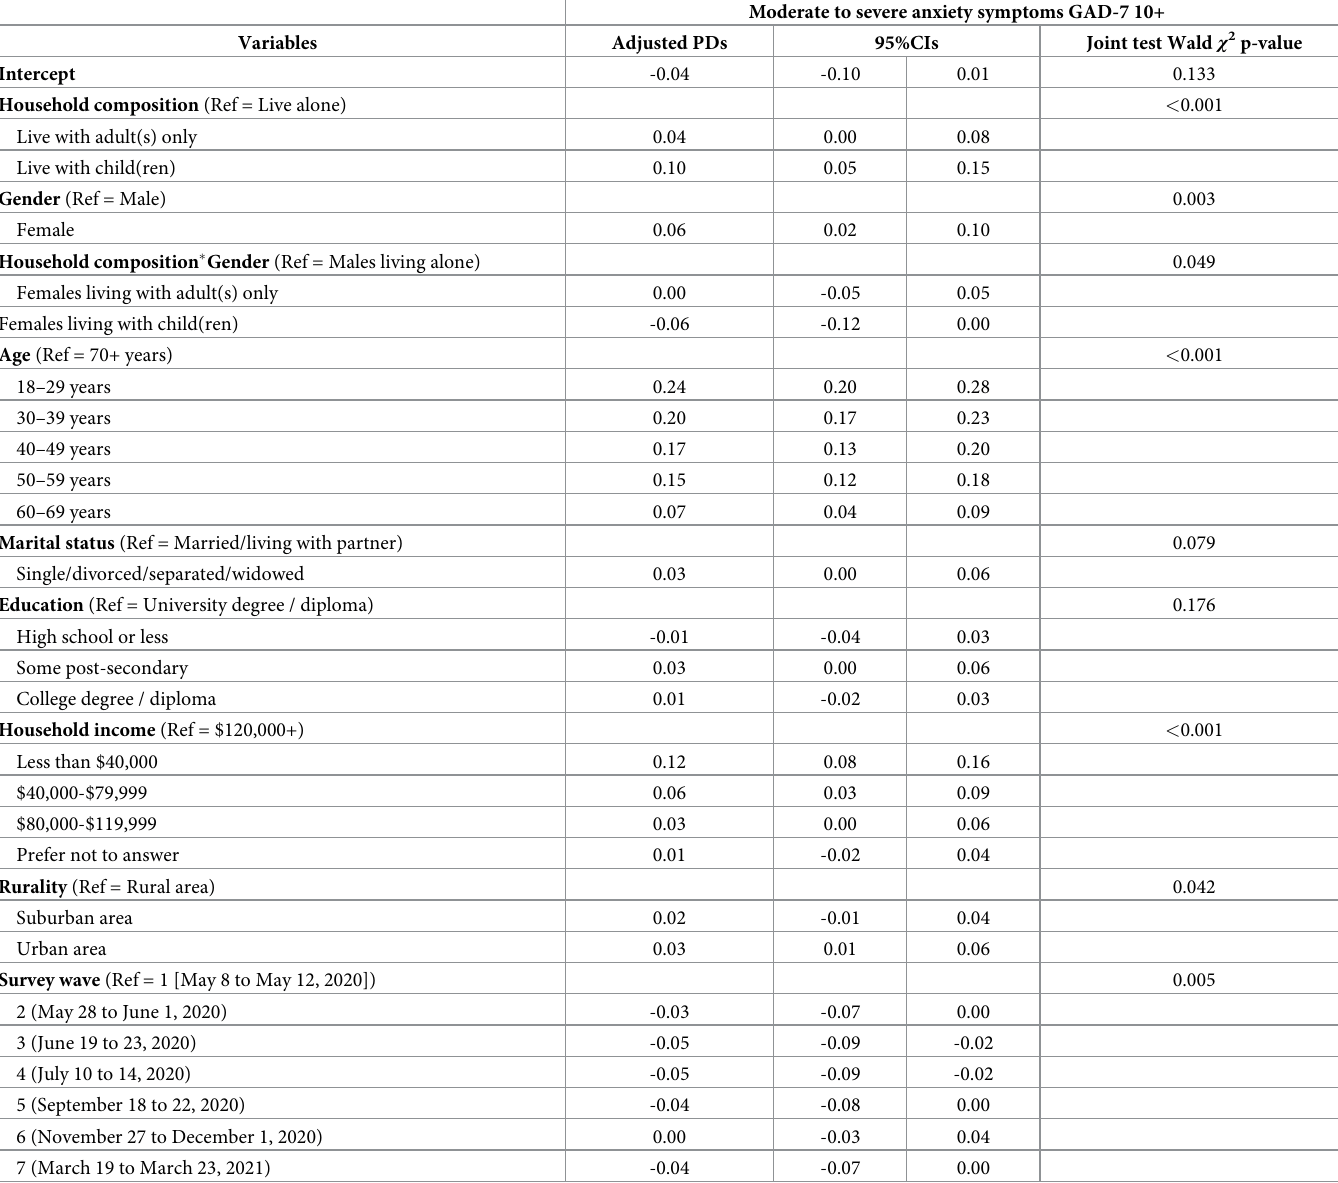
Table 3. Multivariable modified least-squares regression model with robust standard errors for anxiety symptoms (GAD-7 10+) including interaction terms (n =